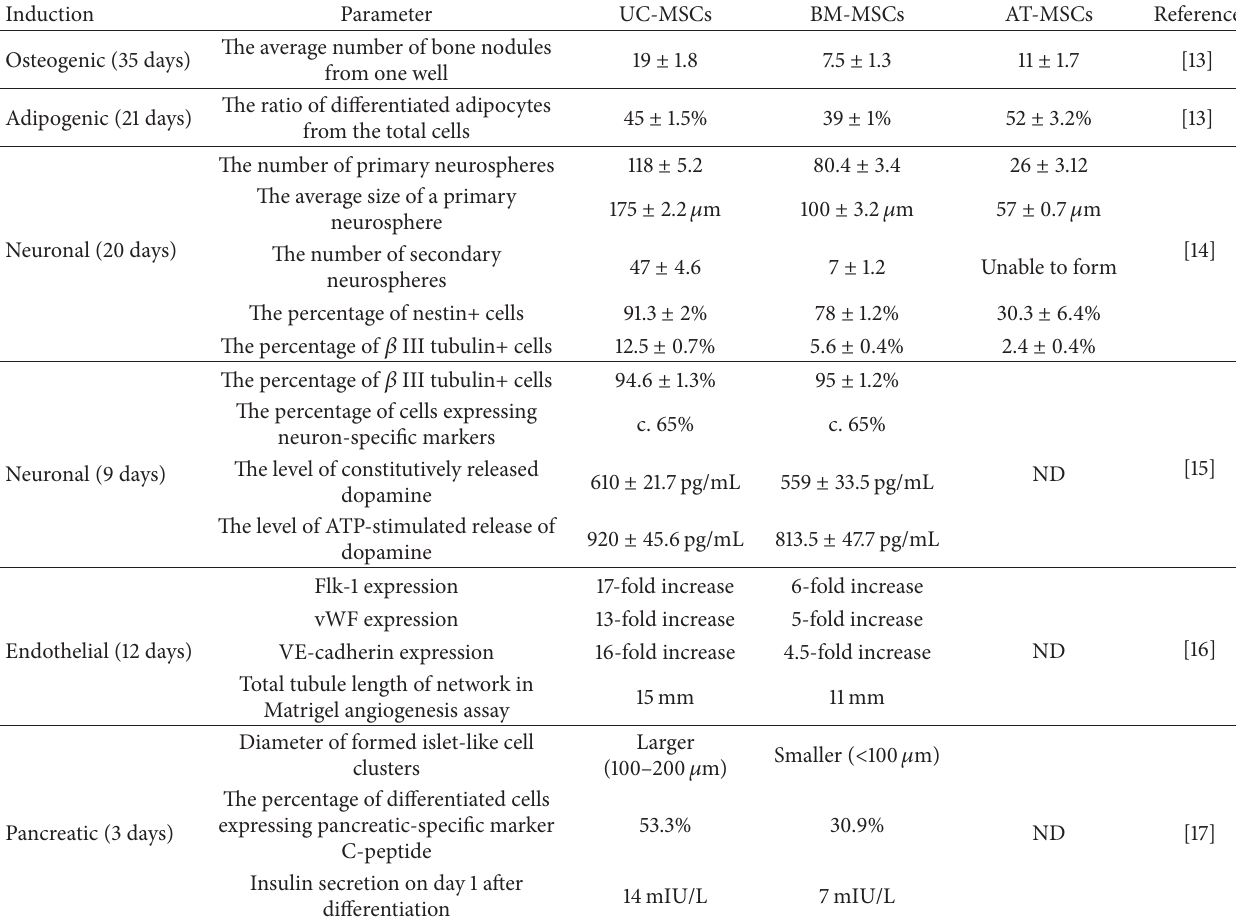
Table 4: Comparison of the differentiation potential of UC-MSCs and MSCs from other